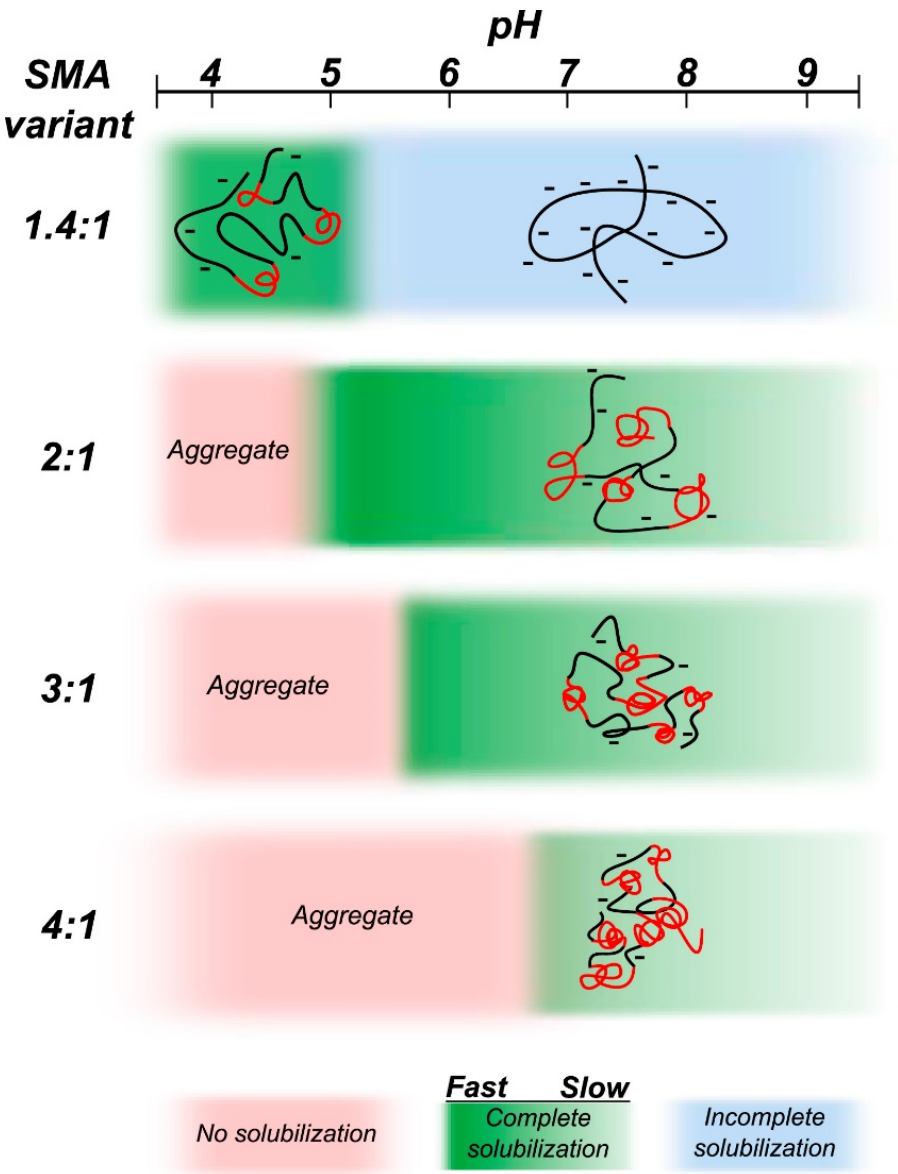
Figure 5. Schematic diagram that summarizes the effects of SMA composition and pH on the molecular conformation and solubilization efficiency of the SMA copolymer. The amphipathic polymer is represented as a cartoon in which the hydrophobic domains enriched in styrene units are shown in red, while the maleic acid-rich hydrophilic part of the polymer is shown in black. The efficiency of cell membrane solubilization is depicted according to color coding. (Dark green) Complete and fast solubilization; (blue) solubilization is induced but remains incomplete; and (red) the polymer is not able to solubilize at all due to self-assembly and aggregation. It should be noted that the exact conditions vary with the protein under investigation. This Figure and caption are adopted from reference [120] with copyright permission.